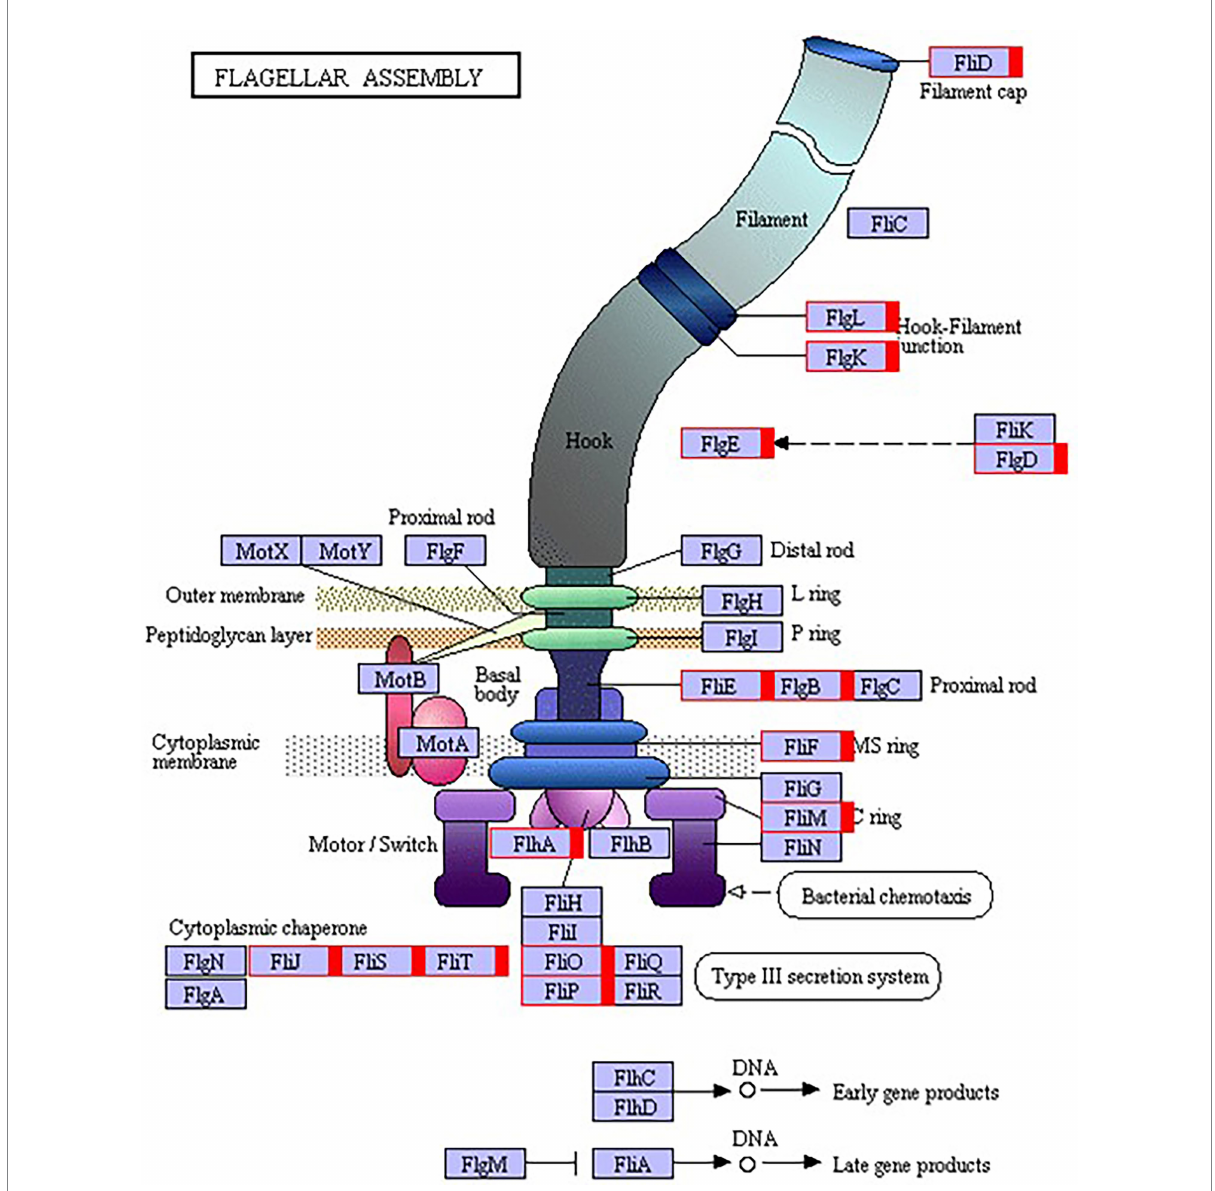
FIGURE 6 Kyoto Encyclopedia of Genes and Genomes (KEGG) pathway annotation of the genes involved in flagella encoding and assembly of B. subtilis 1JN2 after Cd2 + treatment. Genes markered with red indicate